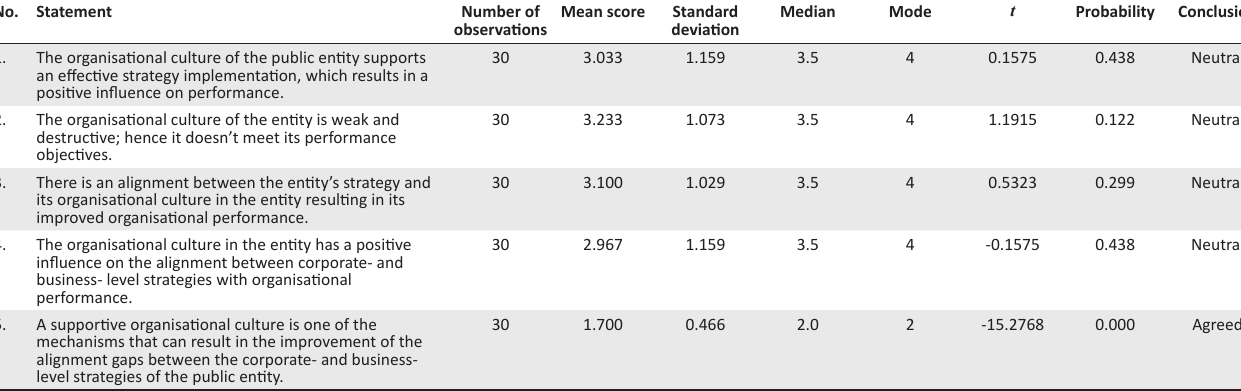
TABLE 2: The role of organisational culture during strategy implementation.